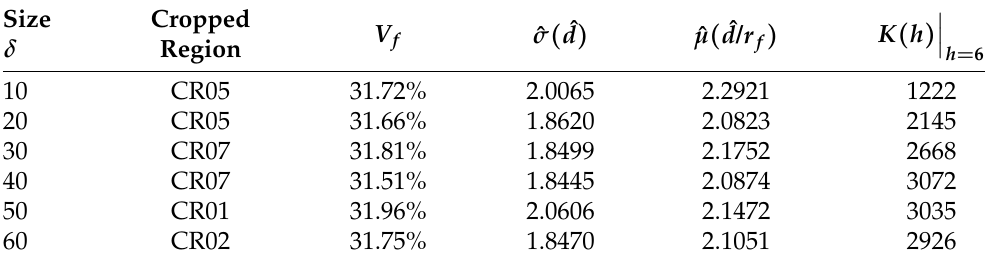
Table 4. Cropped regions and their respective spatial